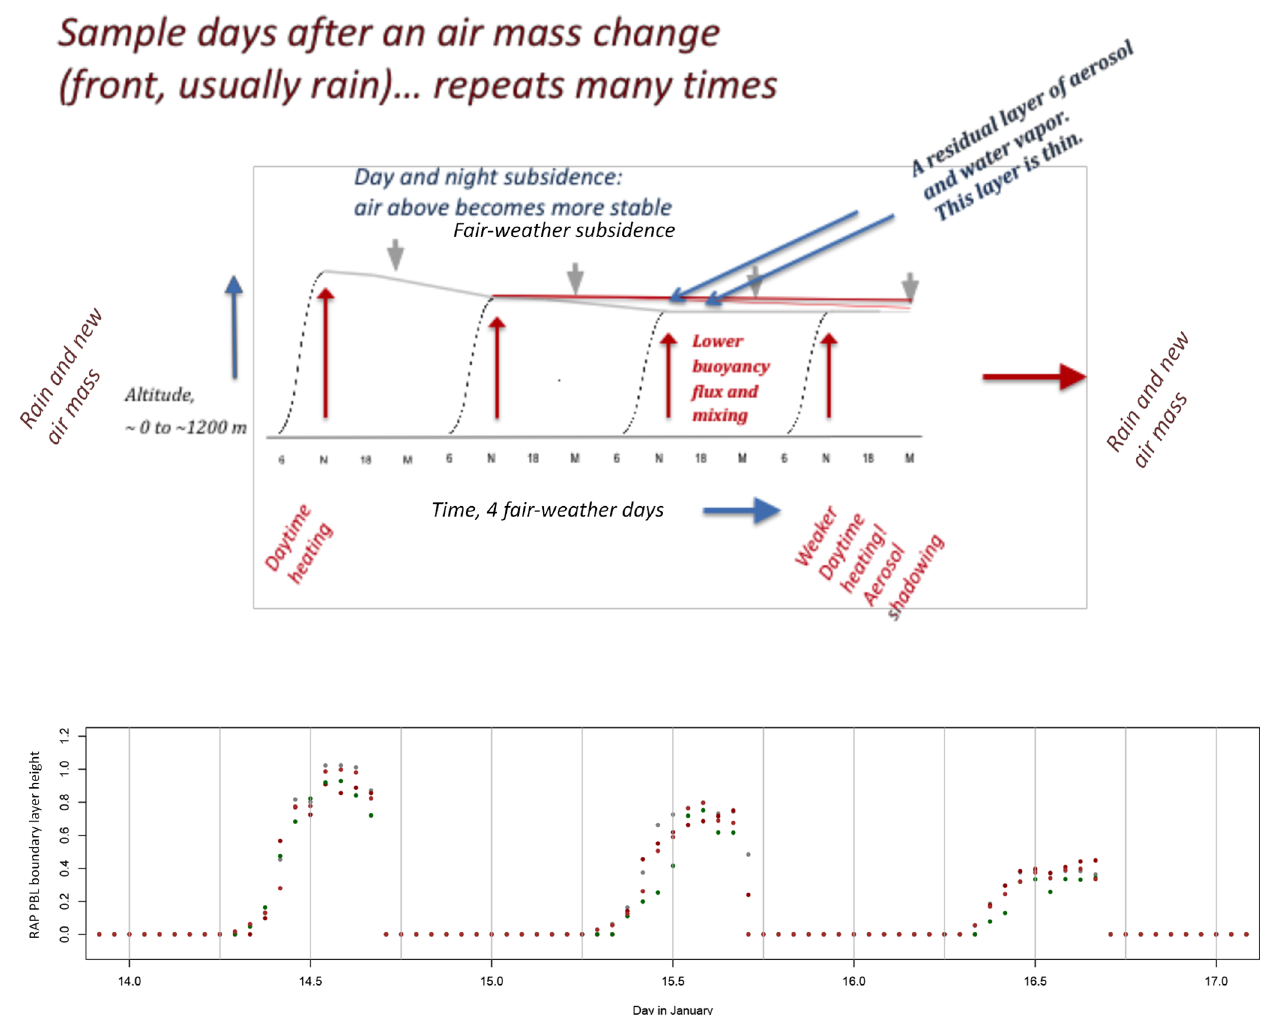
Figure 2. (a) Conceptual figure describing the fair-weather planetary boundary layer (PBL) top for successive days in a clear-weather PM 2 . 5 episode motivating this study; see text. (b) Simulation in the National Oceanic and Atmospheric Administration (NOAA) Rapid Refresh (RAP) model of PBL height for momentum at three SJV PM 2 . 5 stations (red: Tranquility, gray: Hanford, green: Bakersfield). Periods from 11:00 to 15:30UTC approximate the mixed layer for that period and time following, although advection may change the concentrations mixing to that height. Maximum PBL-top altitude may not be accurate for the station, but the shape of diel profile is